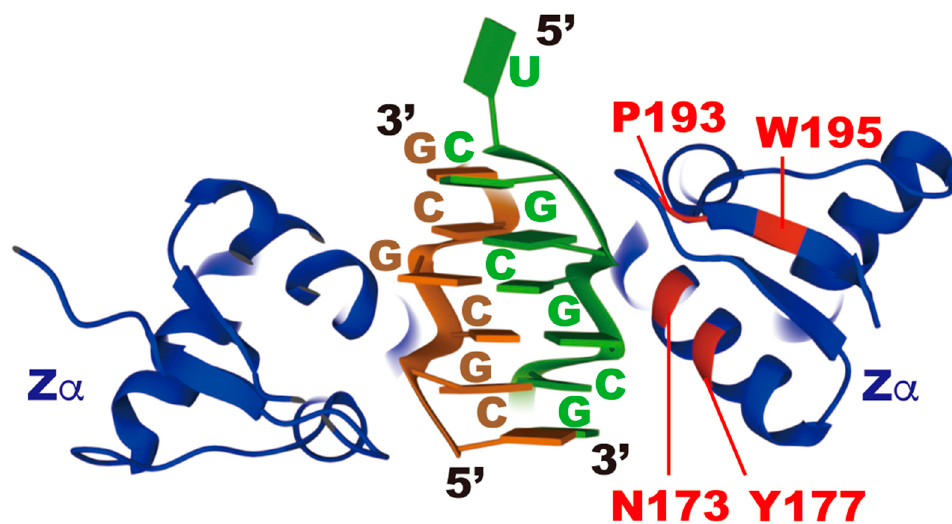
Figure 4. Crystal structure of Z-RNA bound to Z α of ADAR1 p150. Two Z α domains in blue bind to Z-RNA composed of dUr(CG) 3 duplex in brown and green (PDB ID: 2GXB) [59]. Critical residues for Z-DNA/RNA binding (N173 and Y177 in the α helix, and W195 in the β sheet) and residues mutated in patients with AGS (N173 and P193) are shown in red.